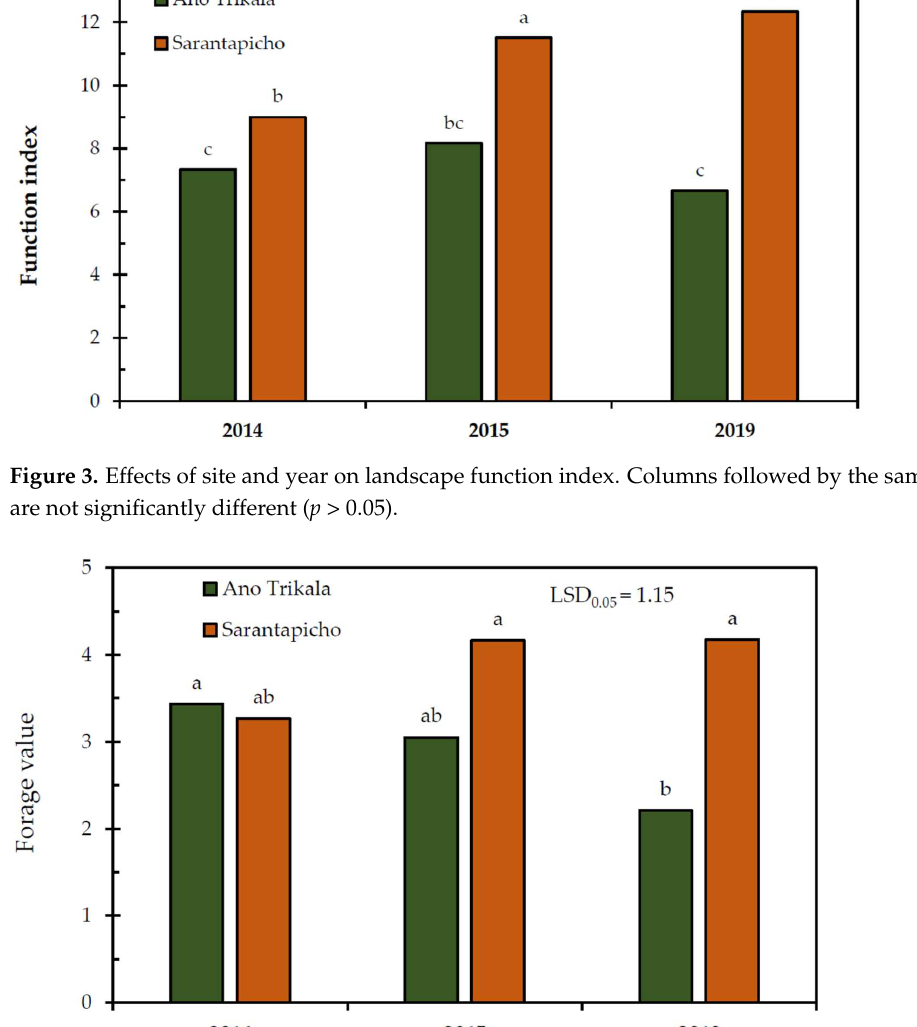
Figure 4. Effects of site and year on forage value index. Columns followed by the same letter are not significantly different ( p > 0.05). significantly different ( p >